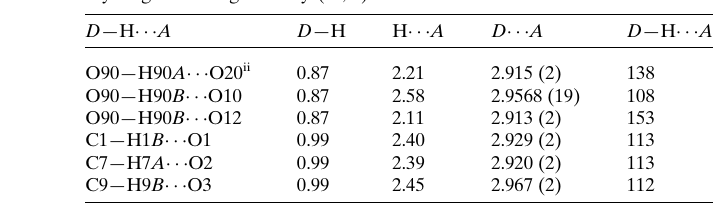
Table 2 Hydrogen-bond geometry (A˚ , (cid:5) ).